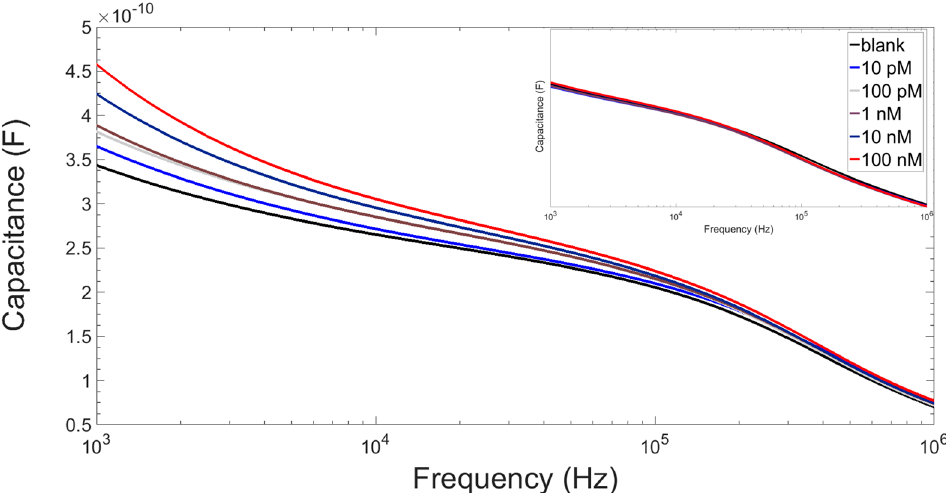
Figure 10. Capacitance profile for a device with a ssPNA probe layer after hybridisation with increasing concentrations of complementary ssDNA. Inset: Capacitance profile for the control device response to complete mismatch non-complementary ssDNA.